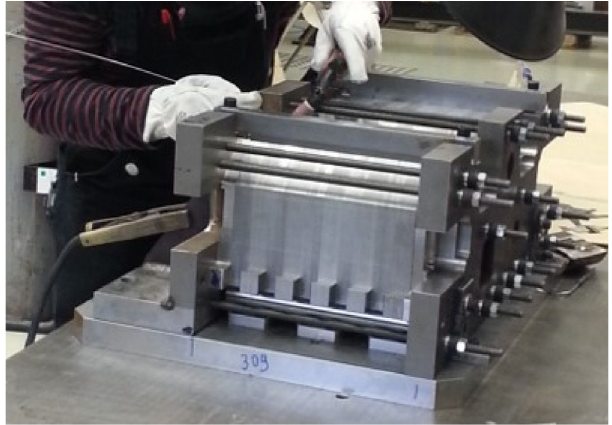
FIG. 12. Stacking of the yoke.